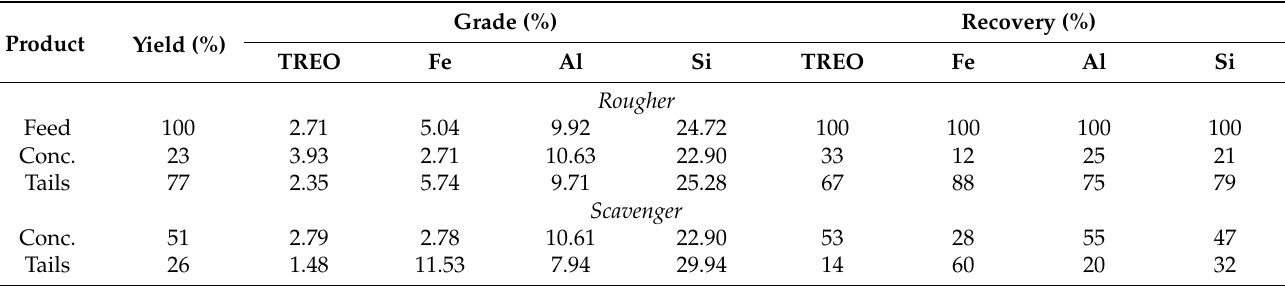
Table 5. Summary of results obtained for Flowsheet III at pH